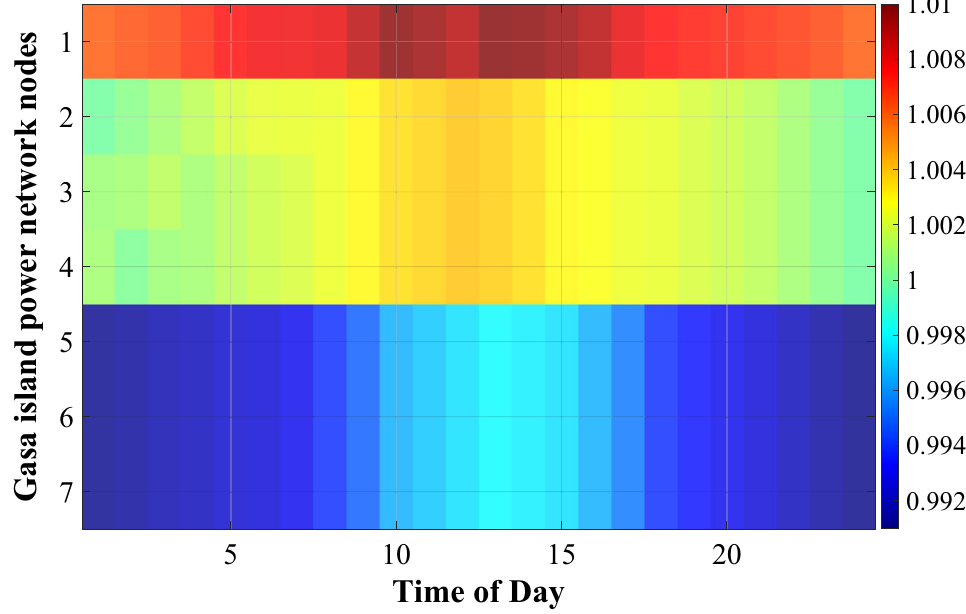
Figure 8. Gasa islands power grid nodes voltage magnitude (p.u.).